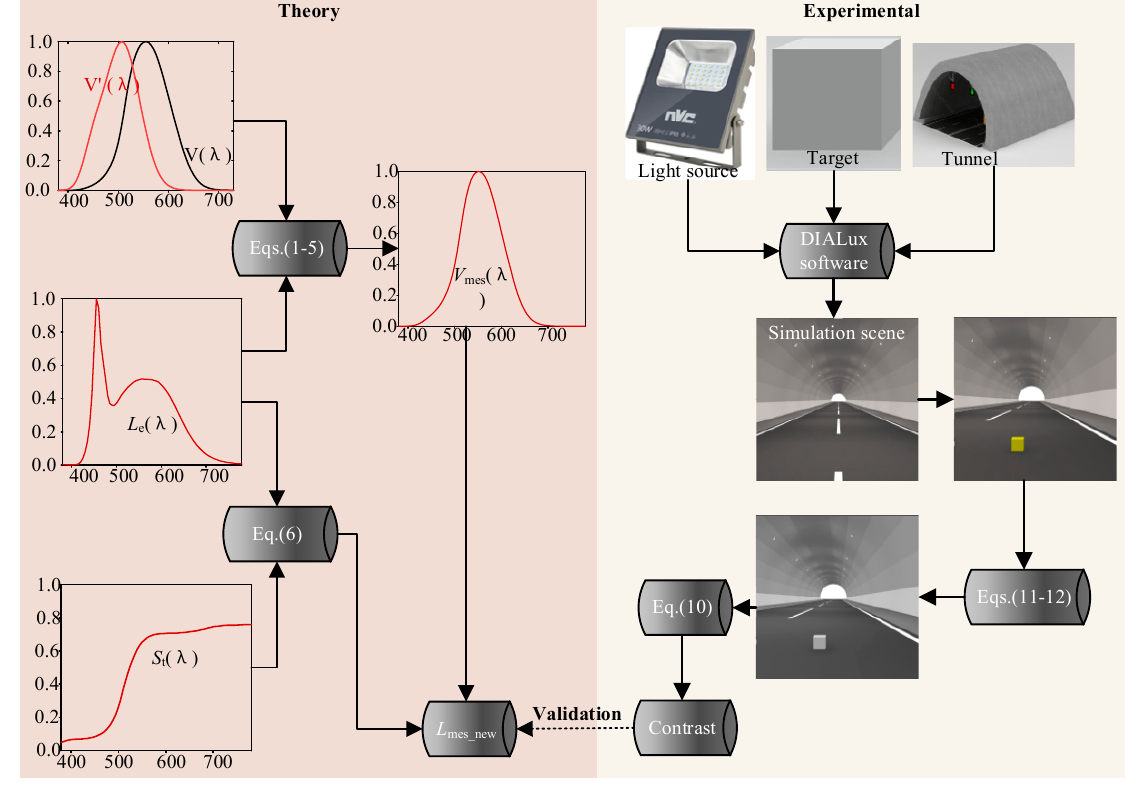
Figure 1. The workflow of the study.